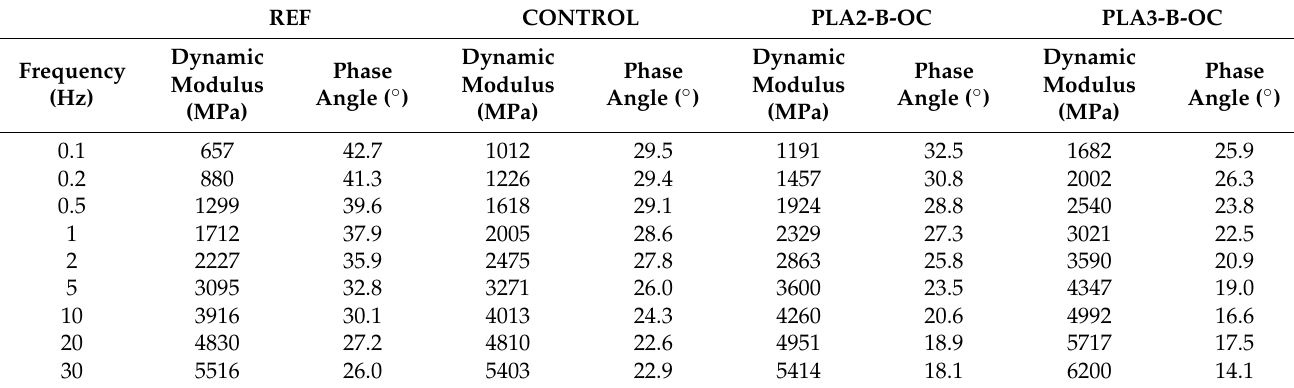
Table 13. Stiffness test of the over-compacted final dosages.